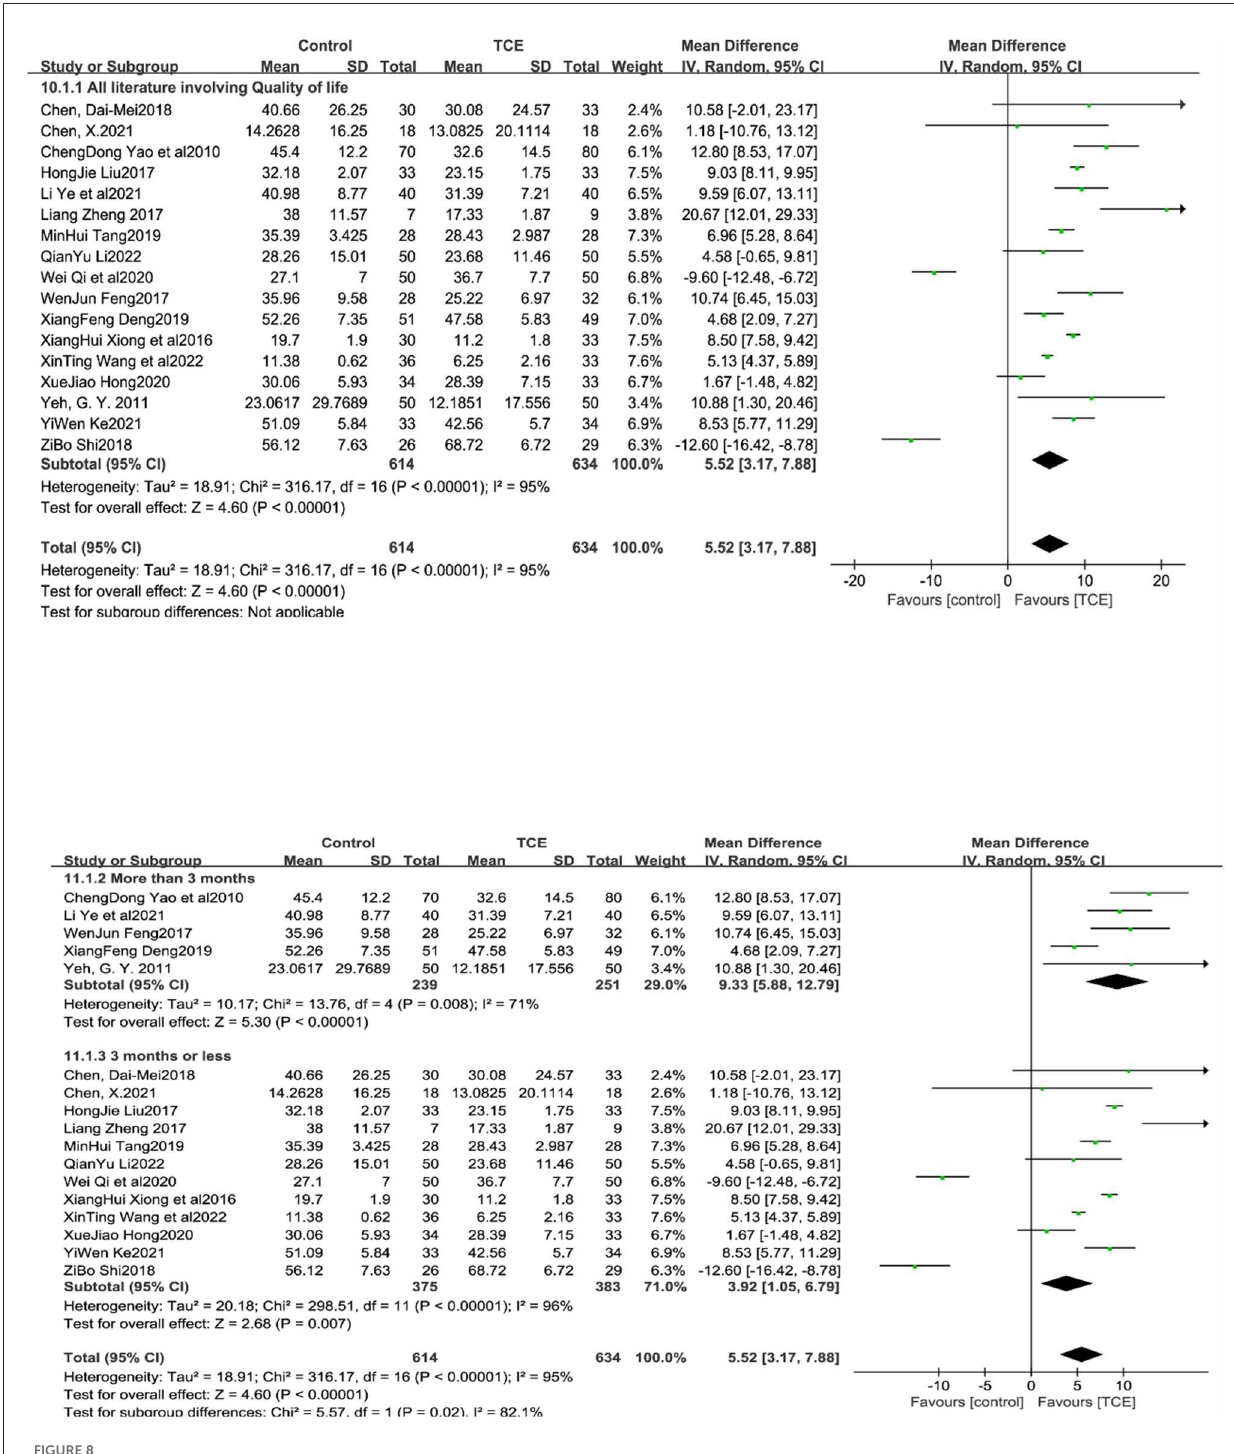
FIGURE8 The effect of Traditional Chinese exercises on patients’ quality of life (included subgroup